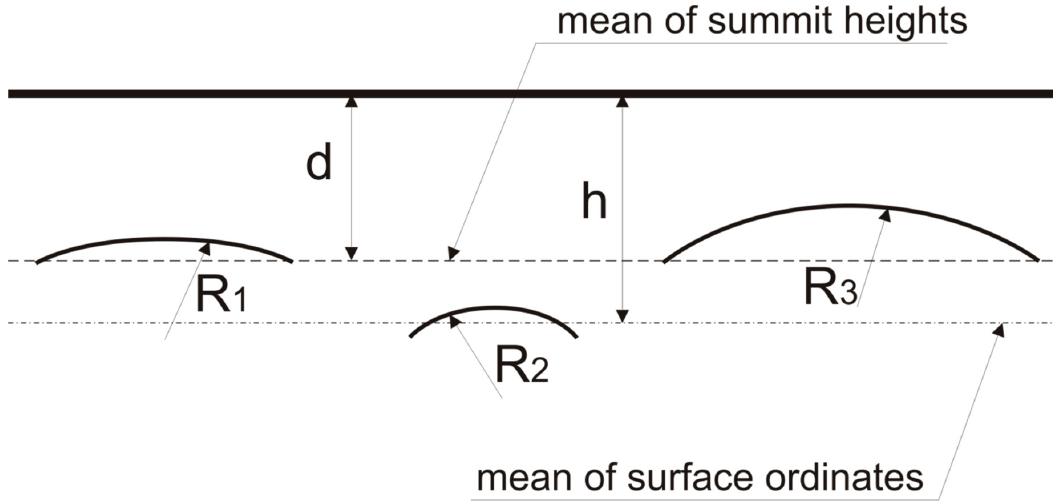
Figure 1. Scheme of the contact of rough surfaces.